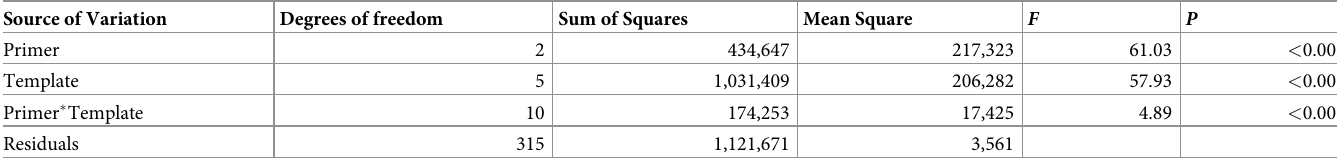
Table 4. Results of fully crossed analysis of variance